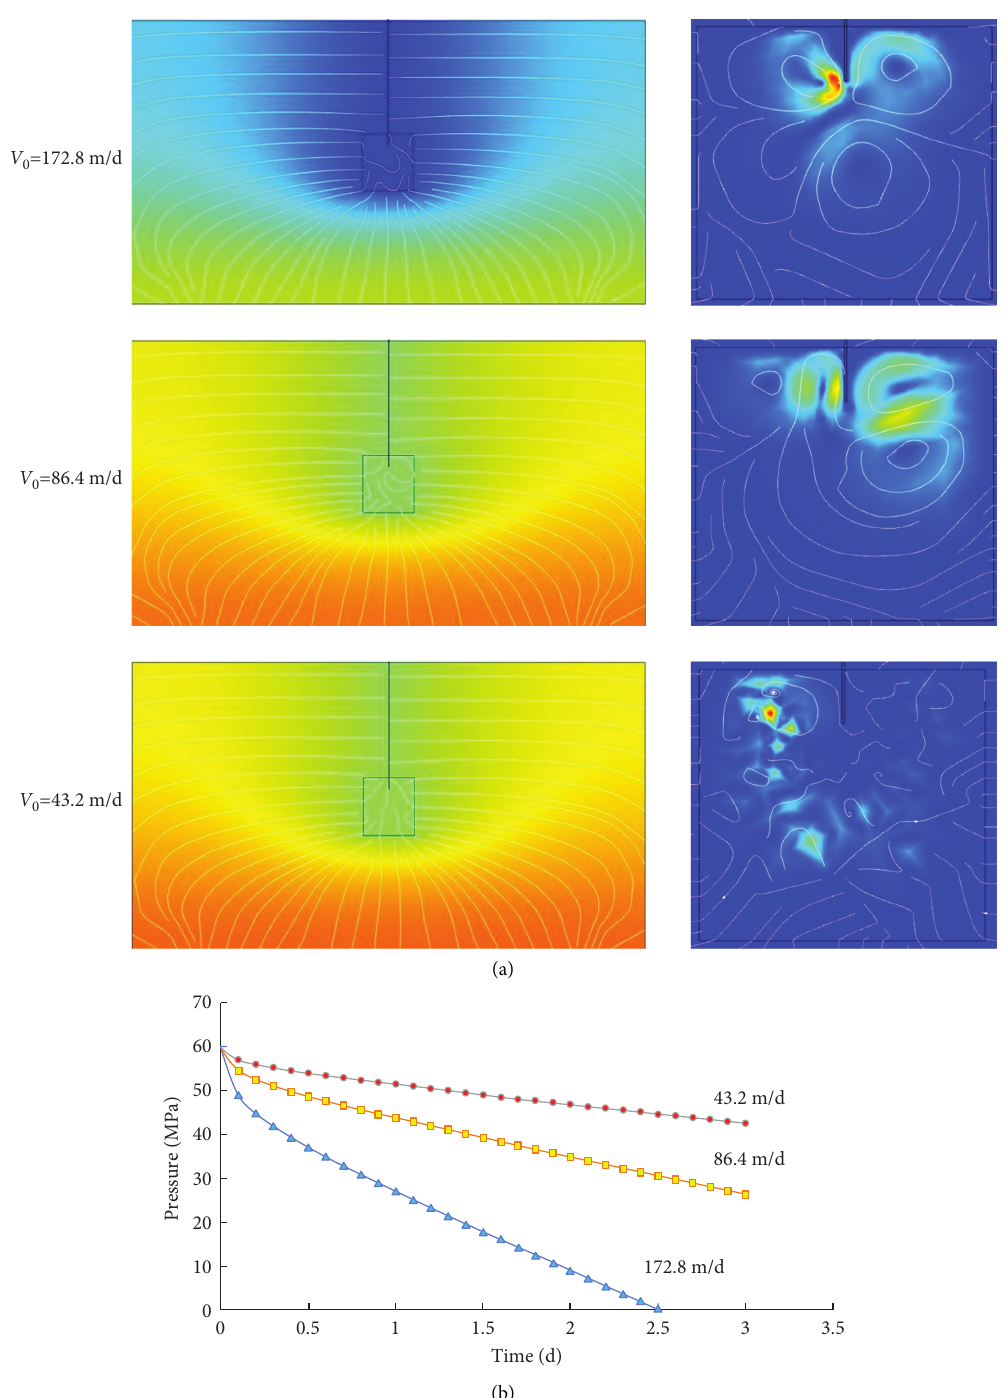
Figure 8: Distribution of pressure and velocity field at different mining rates (a) and pressure comparison of different oil recovery rates